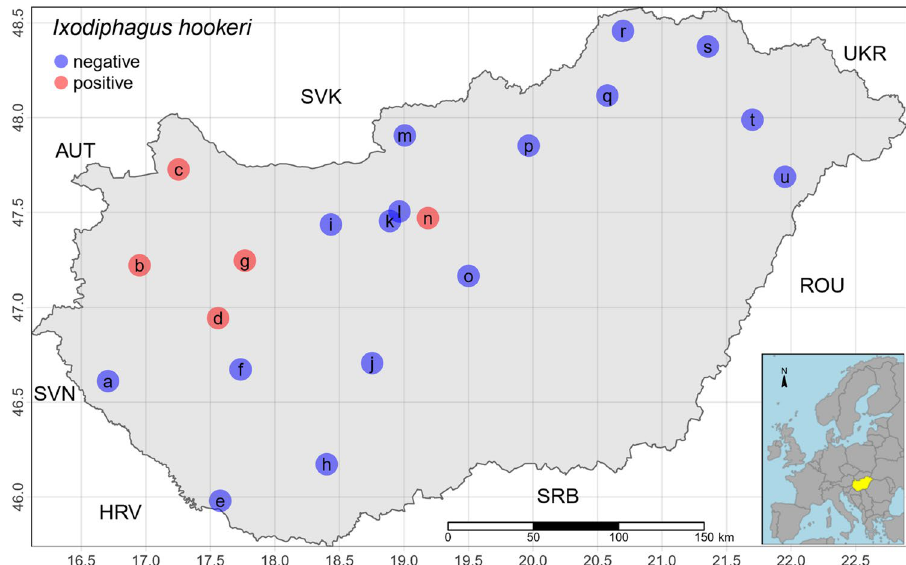
Figure 2. Geopositions of the metagenomically analyzed samples in Hungary. The red dots represent the sampling points we have found I. hookeri sequences, the blue ones where we have not. The inset map shows the study region, Hungary in Europe, colored yellow. Neighboring countries are presented by ISO 3 character codes (AUT: Austria, HRV: Croatia, ROU: Romania, SRB: Serbia, SVK: Slovakia, SVN: Slovenia, UKR: